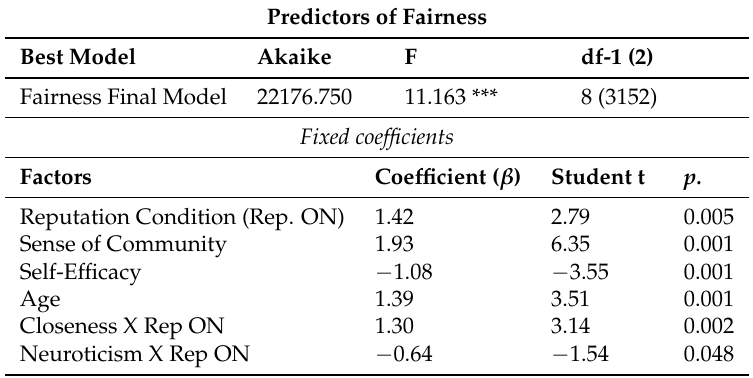
Table 7. GLMM 4. Final Socio-demographic and Psychological predictors fairness across